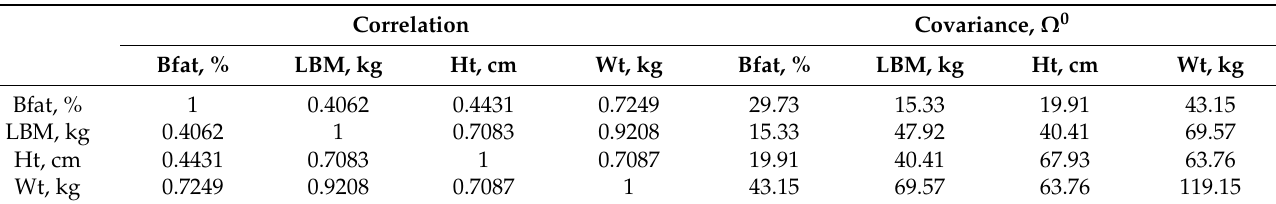
Table 4. Correlation and covariance of AIS data.